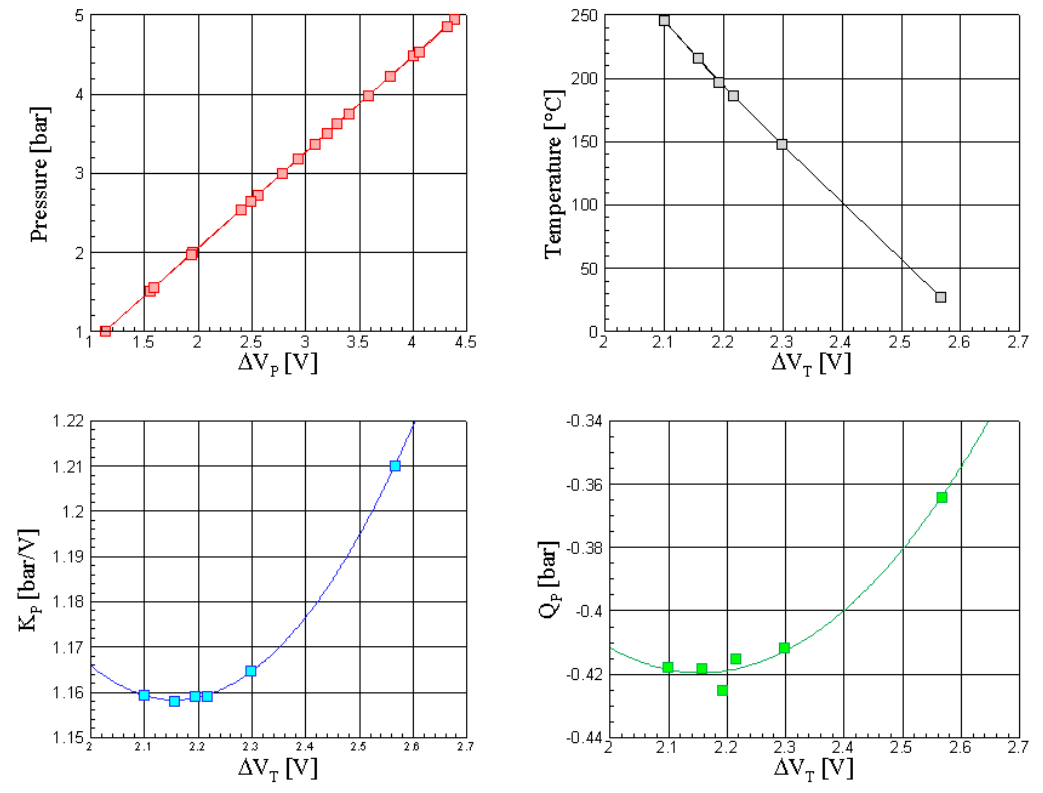
Figure 4. Calibration coefficients: top-left: pressure vs. Δ V P at given temperature; top-right: sensor Temperature vs. ∆ V T ; bottom-left: slope Kp vs. ∆ V T ; bottom-right: intercept Q P vs. ∆ V T.